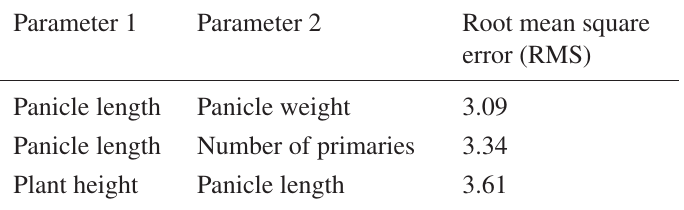
Table 2. Prediction results of two-to-one mappings.